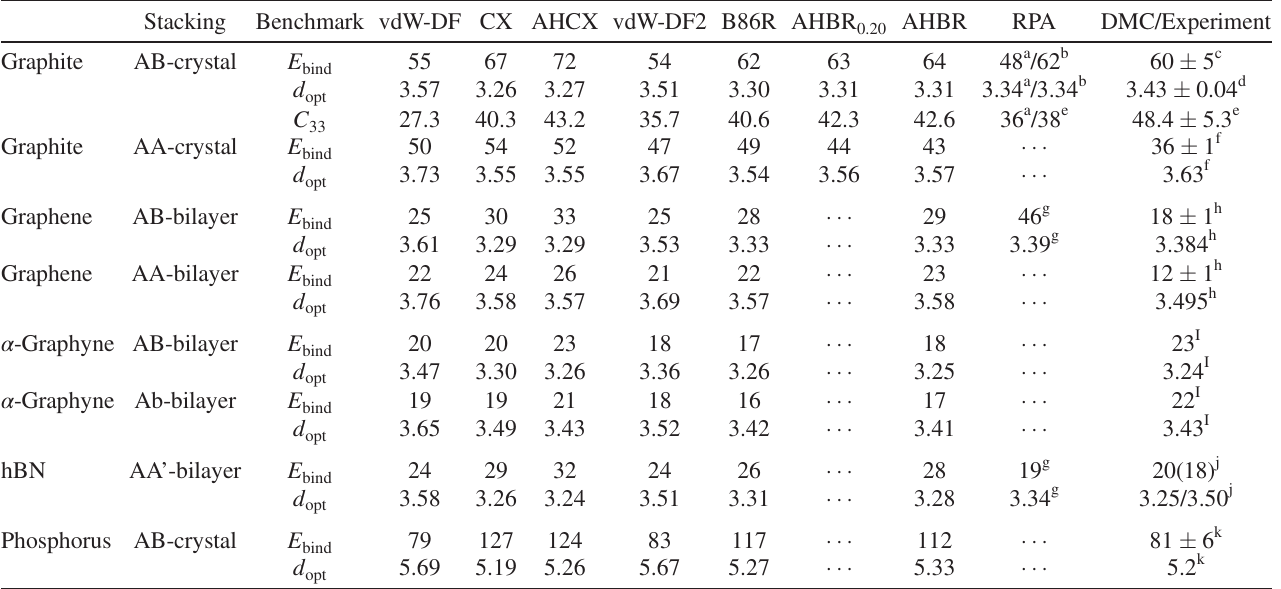
TABLE II. Comparison of vdW-DF performance on layered materials: Layer-binding E (in meV/atom) and optimal layer bind separation d (in Å) for graphite ( sp 2 -hybridized carbon) as well as graphene and α -graphyne bilayers (with sp - sp 2 -hybridized opt carbon), hexagonal boron nitride (hBN) and phosphorus; see DMC Refs. [173 – 177,183] for summaries of in-plane atomic configurations. Stacking labels AA and AB (Ab) identify the geometries with carbon layers in full alignment and displaced one third (one ninth) of the sum of in-plane lattice constants, respectively. Stacking label AA ’ (for hBN) identifies in-plane alignment of boron atoms in one layer with nitrogen atoms in the other layer. For graphite, we also compare computed C 33 values (in GPa) with an experimental result for a high-quality monocrystalline system with a large characteristic domain size 8 . 3 μ